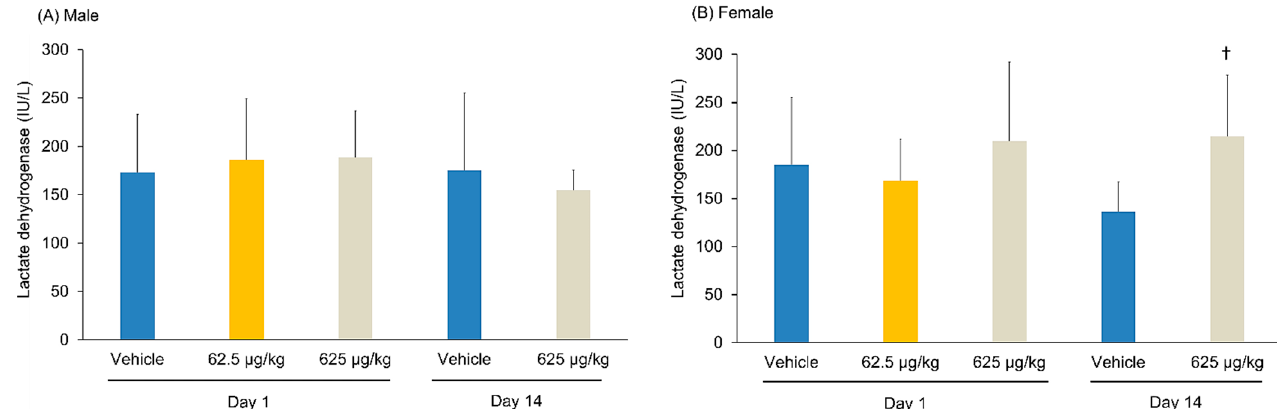
Figure 7. Changes in the activity of lactate dehydrogenase in the blood after the intraperitoneal administration of Cu-NCAB001 into mice. ( A ) Male. ( B ) Female. Values are presented as mean ± SD. The means were calculated based on the following number of values: day 1, vehicle and 625 µ g/kg groups, n = 15; 62.5 µ g/kg group, n = 10; day 14, vehicle and 625 µ g/kg groups, n = 5. As there were no significant differences in histopathological observations between the 625 µ g/kg-treated and control groups on day 1, the 62.5 µ g/kg-treated group was not subjected to assessment on day 14. † p ≤ 0.05 vs. vehicle group on the same day ( t -test, two-side).